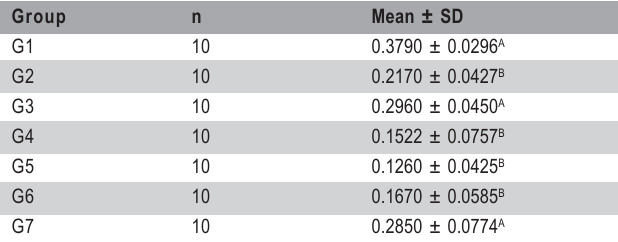
Table 1 - Amount of material emoved at 2 mm level (measured from outside).